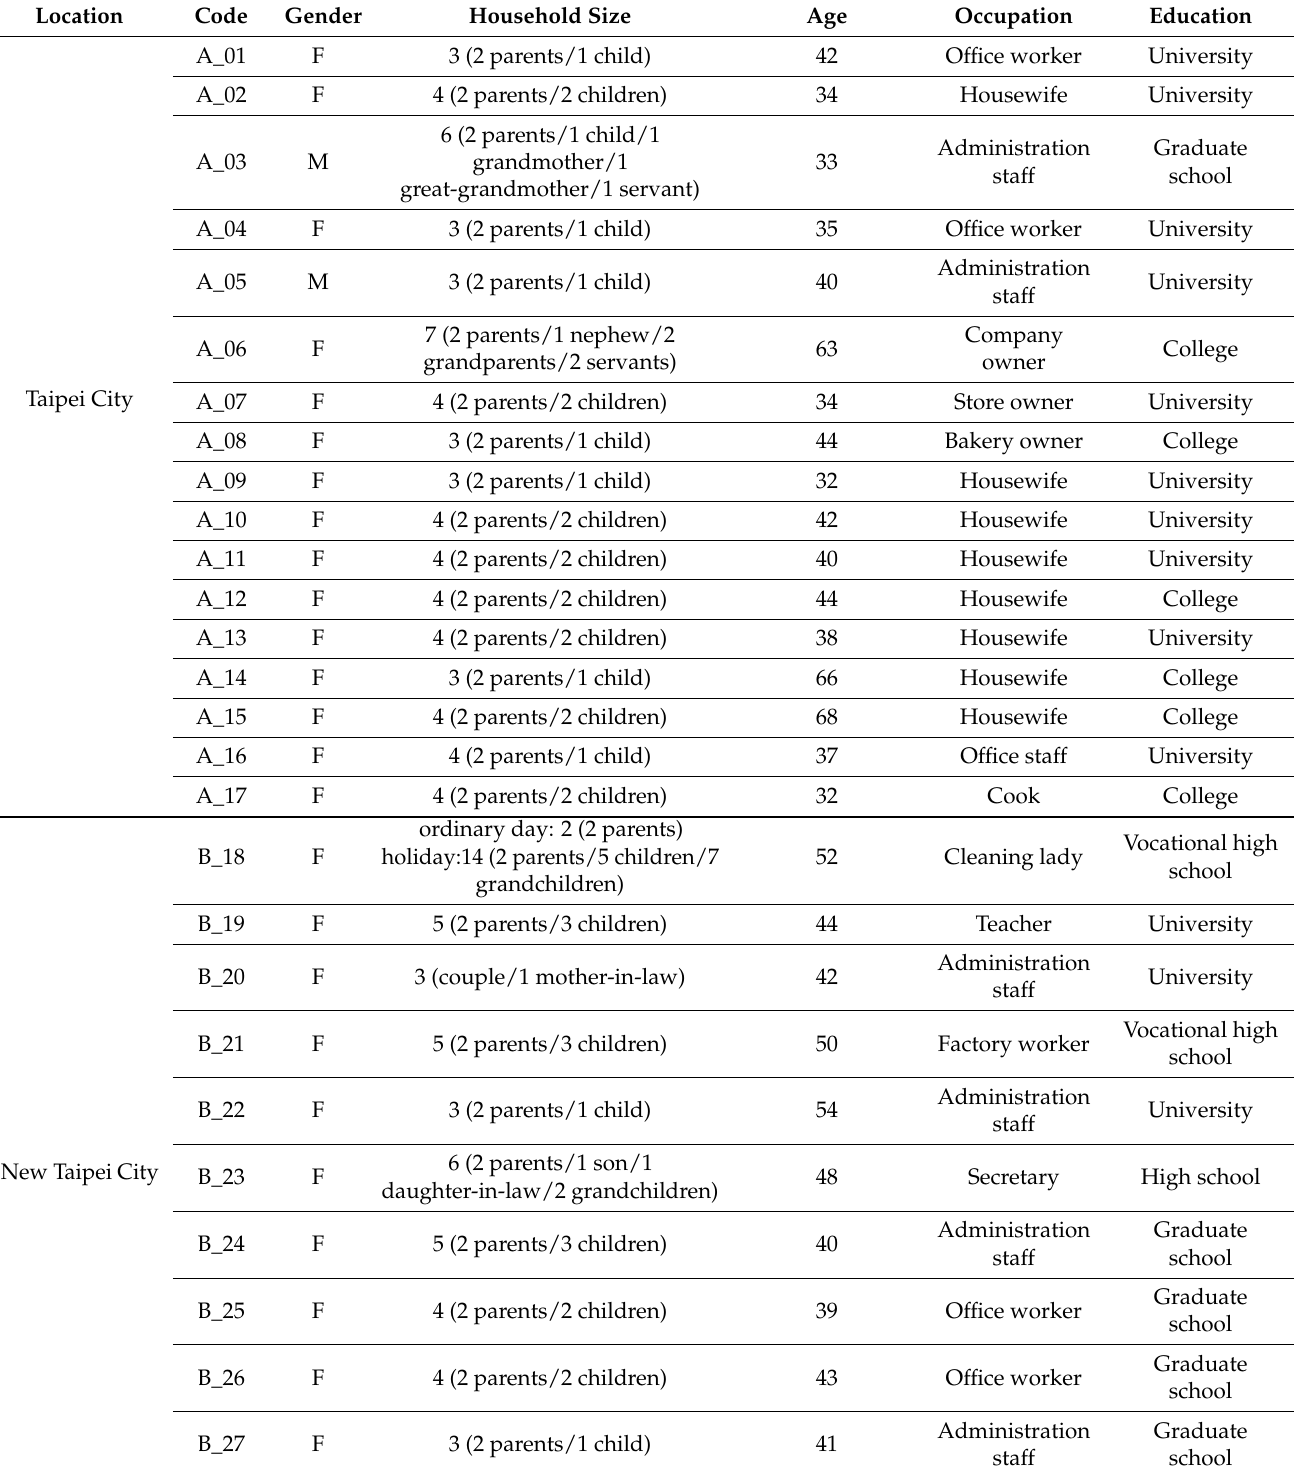
Table 2. Demographic information of the